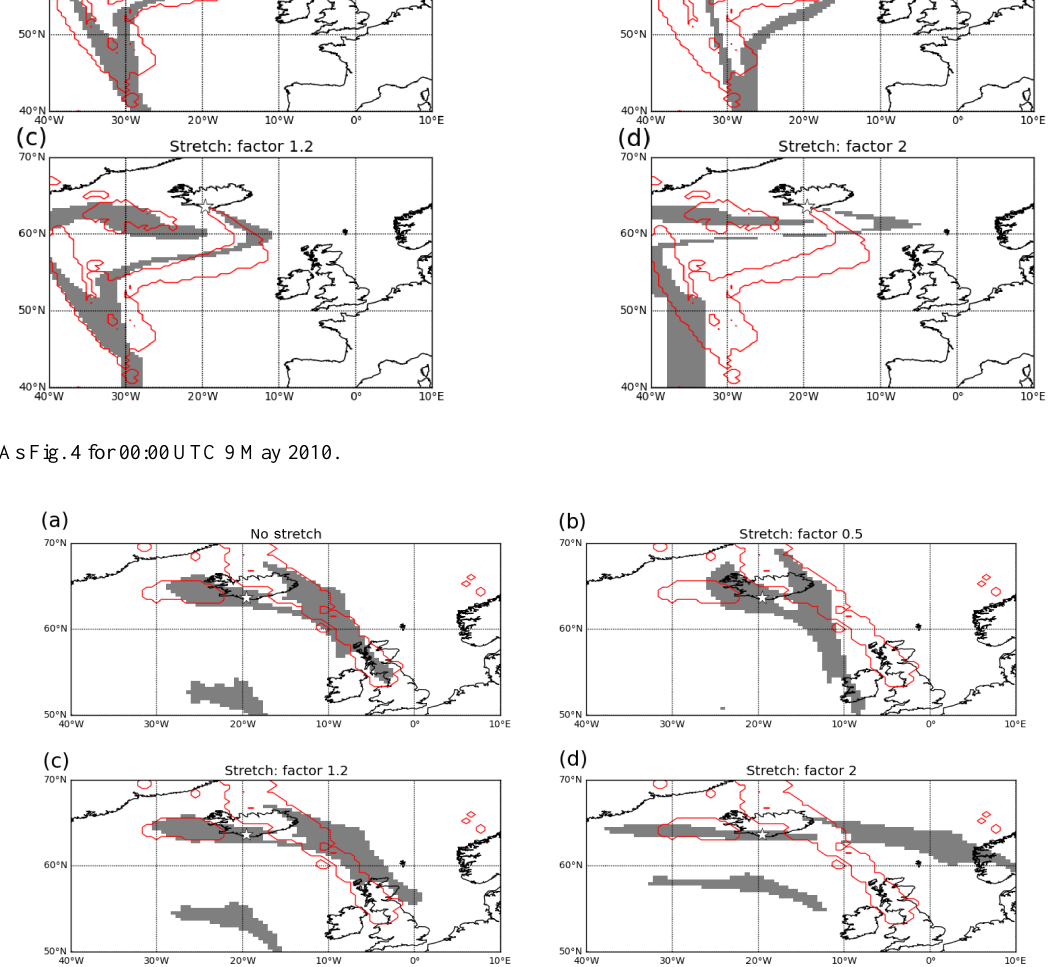
Figure 7. As Fig. 4 for 12:00UTC 14 May